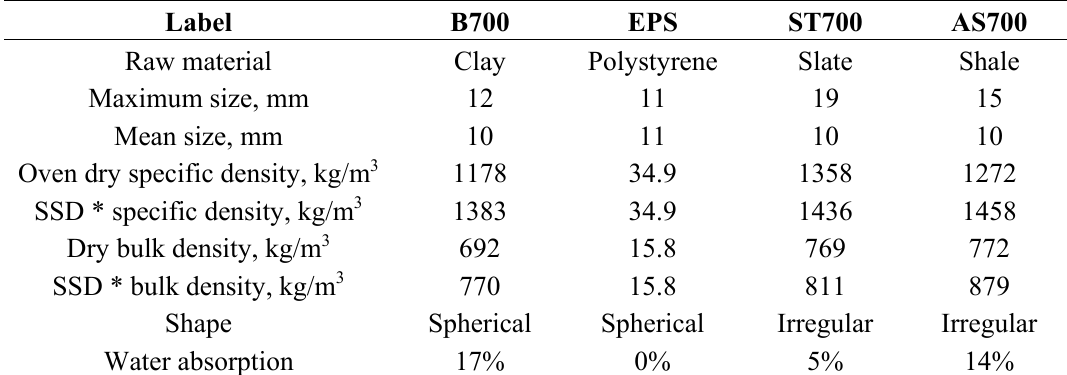
Figure 1. Particle size distribution of Portland cement. Table 2. Types of lightweight aggregates and their